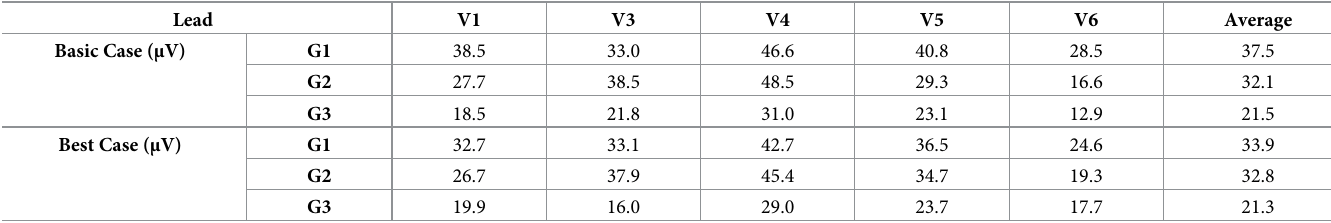
Table 3. Absolute means of the amplitude gaps.